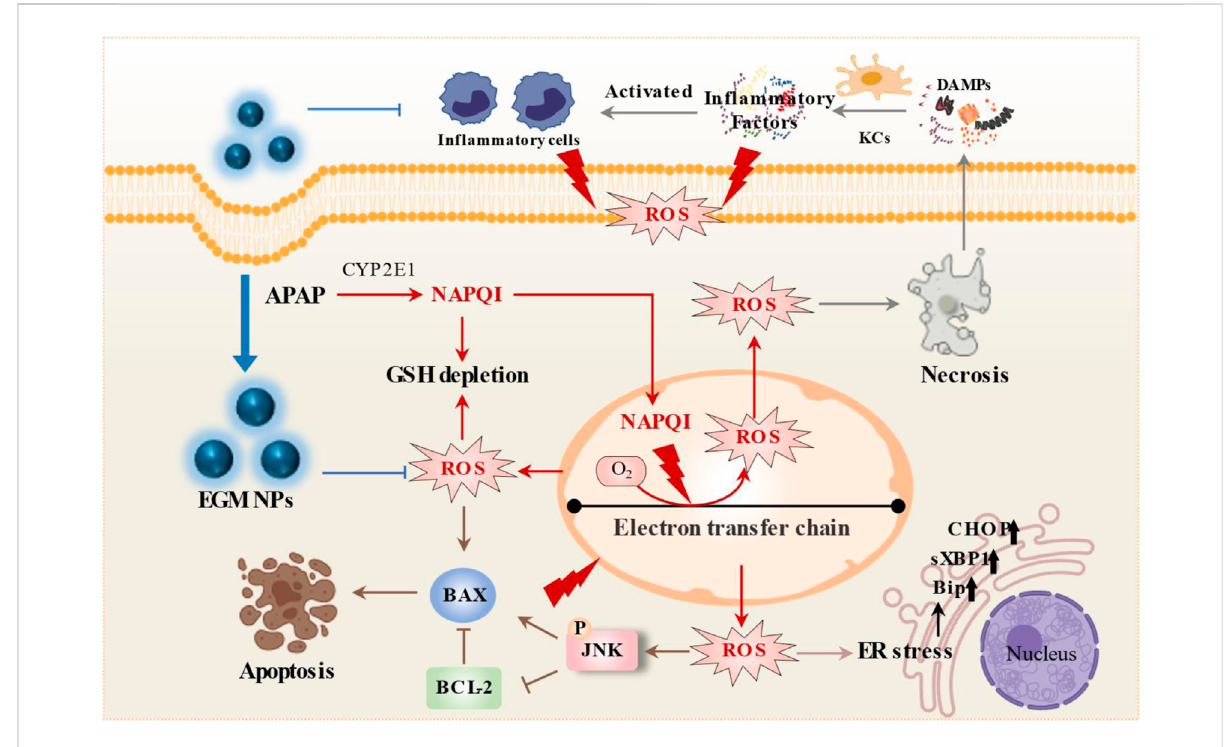
FIGURE 8 Schematic illustration of therapeutic mechanism of TWNDs for APAP-induced liver